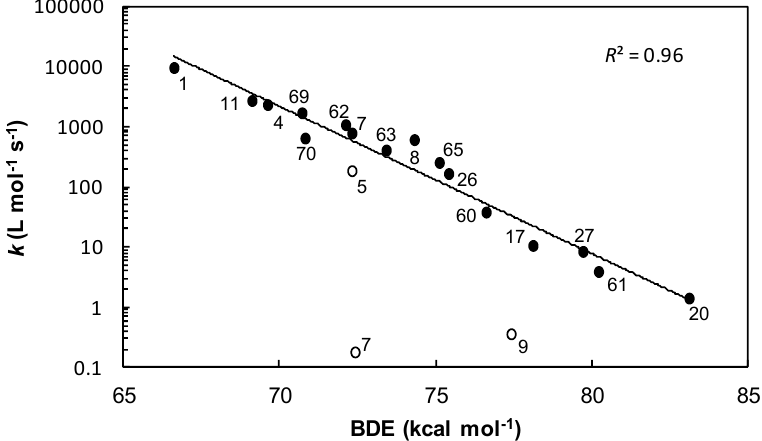
Figure 13. Logarithm of the rate constants (log k) for the reaction of phenolic antioxidants with DPPH • ( ο hindered phenols and ● other phenols) in toluene as a function of their BDEs calculated with the B3LYP/6-311++G(2d,2p)//B3LYP/6-311G(d,p) density functional theory (DFT) method. Nevertheless, due to the steric hindrance of the phenolic hydrogen, kinetic rates are sharply slowed down for BHA 5 , BHT 7 and o-tert -butyl- p -cresol 9 . Therefore, kinetic rates k are very low